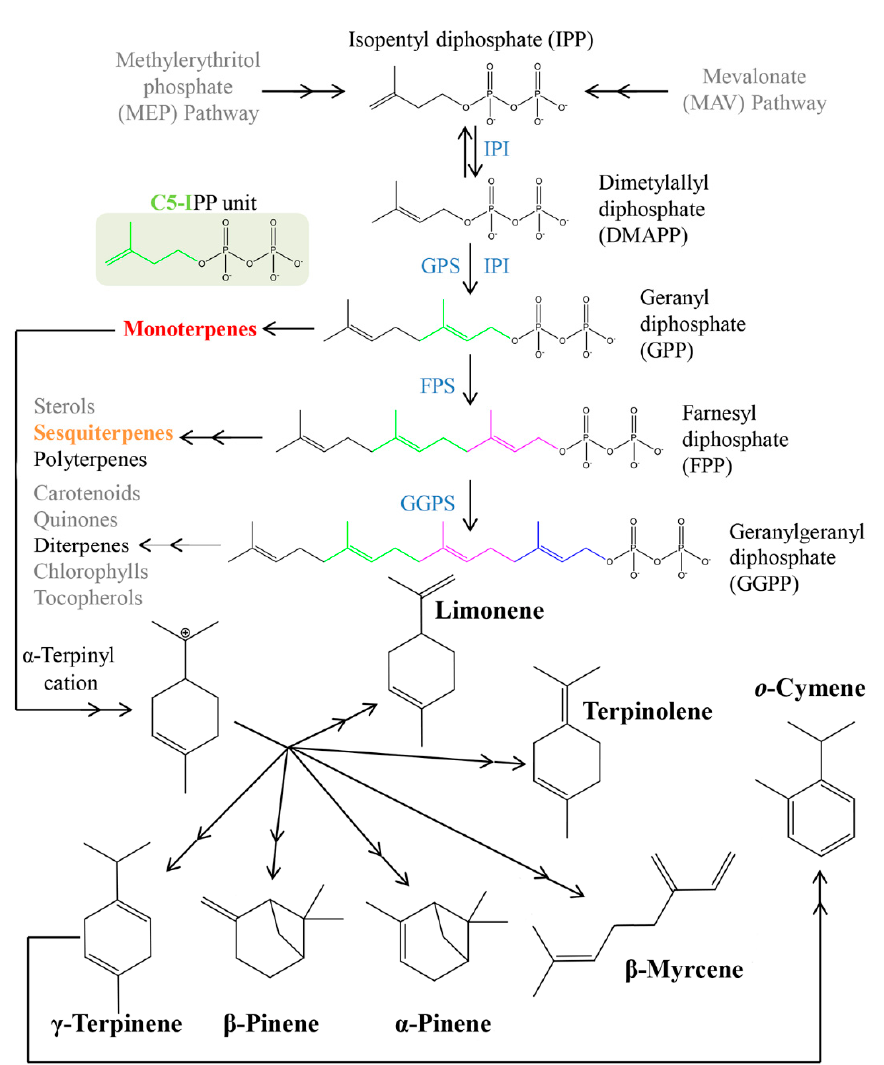
Figure 3. Main reactions cascade involved in the formation of the most abundant terpenoids identified in this work (adapted from [15]).